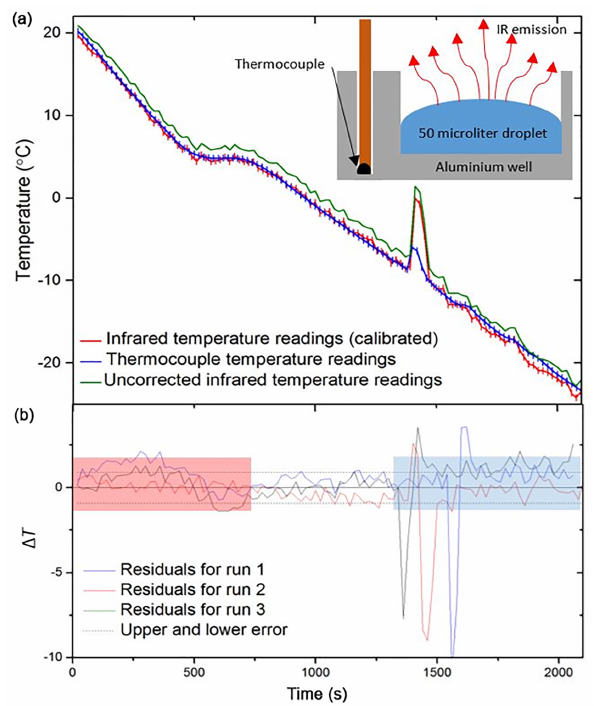
Figure 3. Tests of the IR temperature measurement using alu- minium wells with embedded thermocouples (i.e. not using the standard multiwell plates). (a) The temperature measurement from a thermocouple (shown in blue) placed within an aluminium well vs. infrared measurements taken using the IR camera. Uncorrected IR data are shown in green, whilst corrected IR data following the calibration described in Sect. 2.2 are shown in red. Inset is a schematic of the experimental setup. (b) The difference in tem- perature (residual; (cid:49)T ) between the thermocouple readings for three aluminium wells and the corresponding IR data ( (cid:49)T = T IR − T Thermocouple .). The negative spikes are a result of the IR camera directly reading the water temperature as it is heated by ice forma- tion, whereas the thermocouple measurement is reading the tem- perature of the aluminium well, which is less affected by the latent heat release. The estimated error in temperature for the IR camera of ± 0 . 9 ◦ C is indicated with dashed lines. The range over which freezing occurs is highlighted with a blue rectangle as this is where the thermal properties of ice and the initiation of heat release affect the temperature readings. Highlighted in red is the section of data before the well has equilibrated, and so the IR camera is likely read- ing a warmer surface temperature than the thermocouple. See text for discussion.